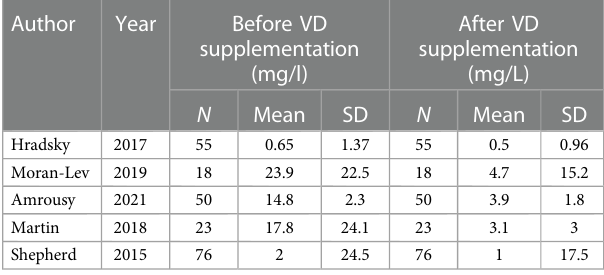
TABLE 3 The CRP levels in IBD patients before and after VD supplementation.